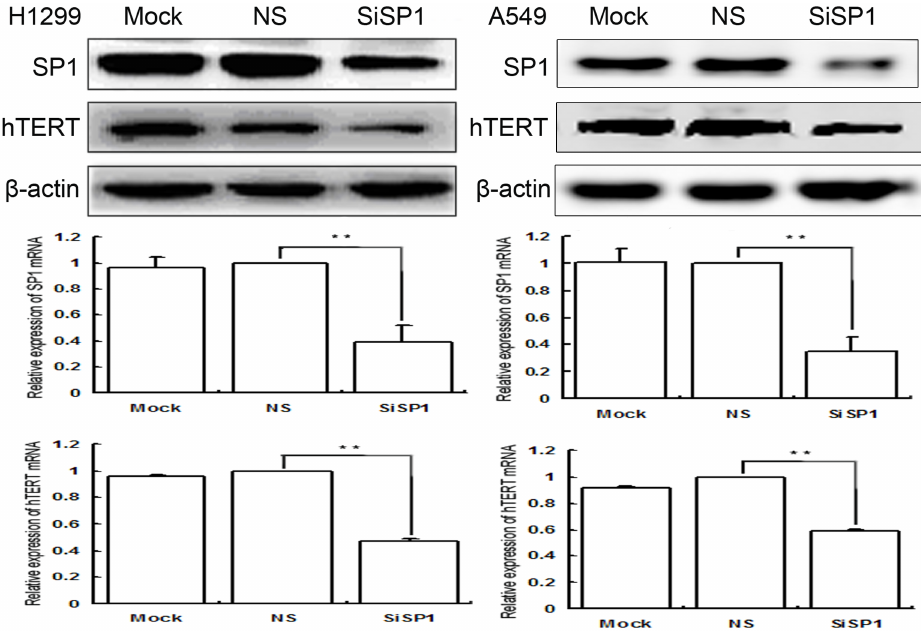
Fig 2. Low expression of SP1 and hTERT was in H1299and A549 cells. Detection the expressionof both protein and mRNA of them was in lung cancer cells as well as in control cells by Western blot and qRT-PCR. Mock mock-specific siRNA, NS nonspecific siRNA, SiSP1 SP1-specific siRNA ( ** P < 0.01). β -actinserved as